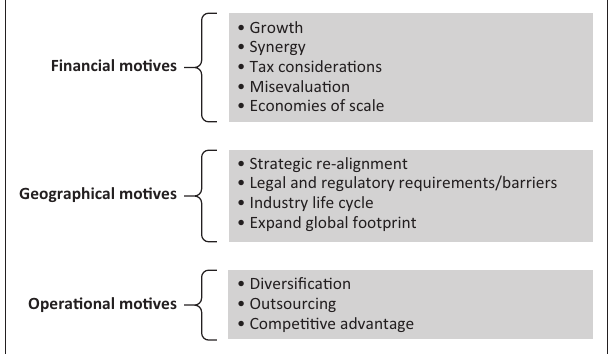
FIG URE 1: Common motivations behind mergers and acquisition